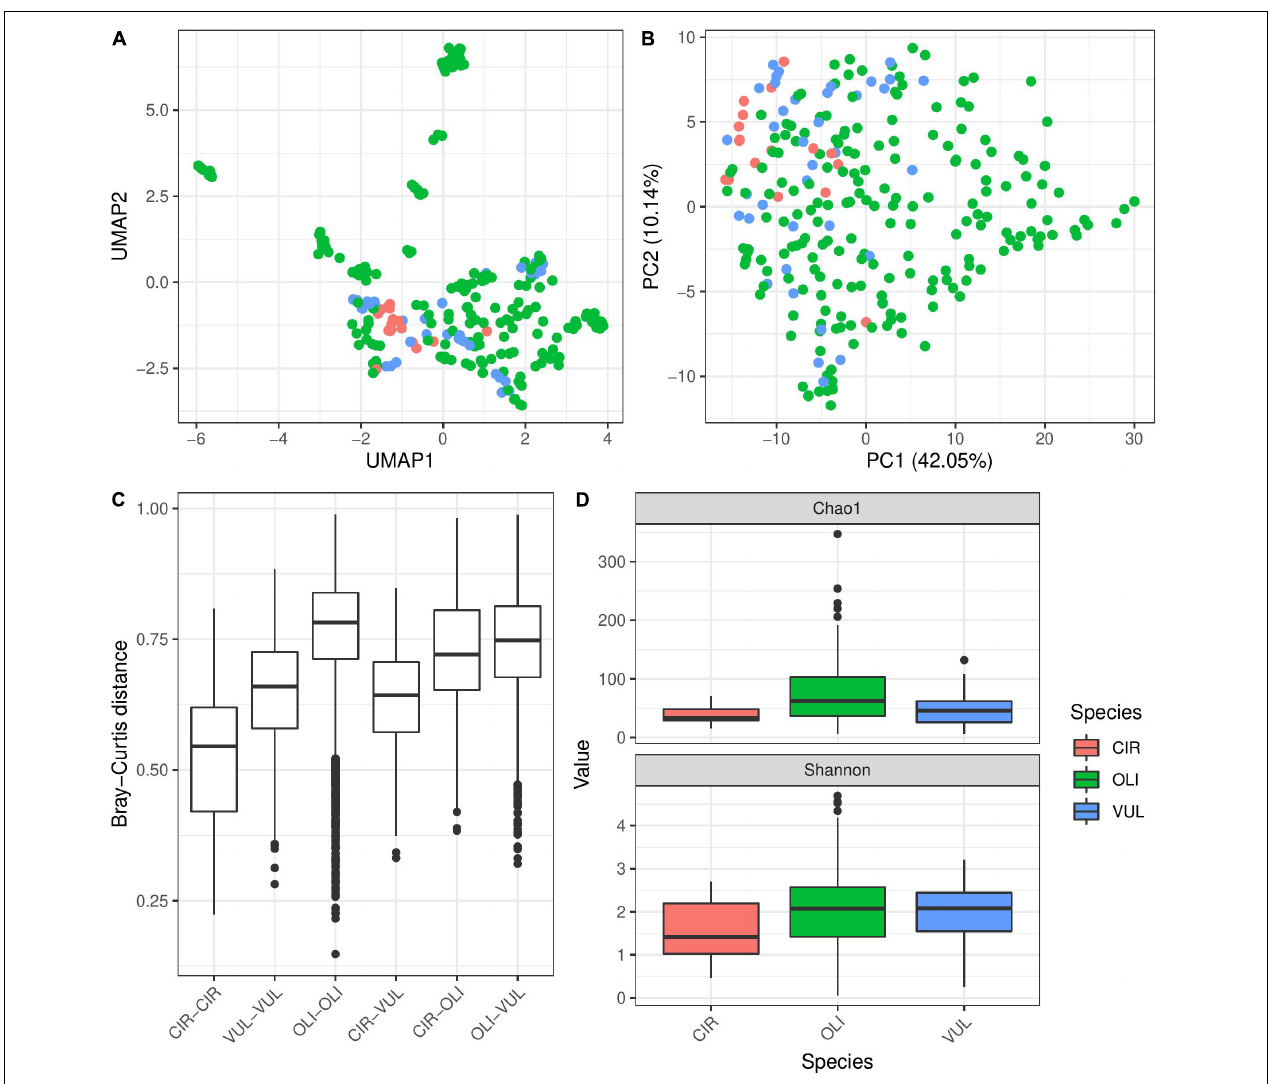
FIGURE 5 | The influence of host species on microbial diversity in Hydra . UMAP (A) and PCA (B) ordination plots for the Bray–Curtis dissimilarity show moderate clustering of samples by species. The clustering is supported by testing for differences in Bray–Curtis dissimilarity by PERMANOVA ( R 2 = 0.04, p ≤ 0.001 with 999 permutations, univariate and multivariate models, Table 2 ). The boxplot for Bray–Curtis dissimilarity (C) shows reduced values for β -diversity within H. circumcincta samples compared to the rest, while H. oligactis seems to have largest dissimilarity values within one species, indicating that H. oligactis is able to host a more diverse microbial community than the other species. The dissimilarity between H. circumcincta and H. vulgaris is generally smaller than between the other species pairs indicating more similar microbial communities between these two species. α -diversity (D) is similarly affected by the host species ( p = 0.089 and p ≤ 0.001 for univariate linear model and multivariate linear mixed model, respectively Table 3 ). H. circumcincta showed the lowest α -diversity, which was also significantly different compared to the other species ( Supplementary Table 3